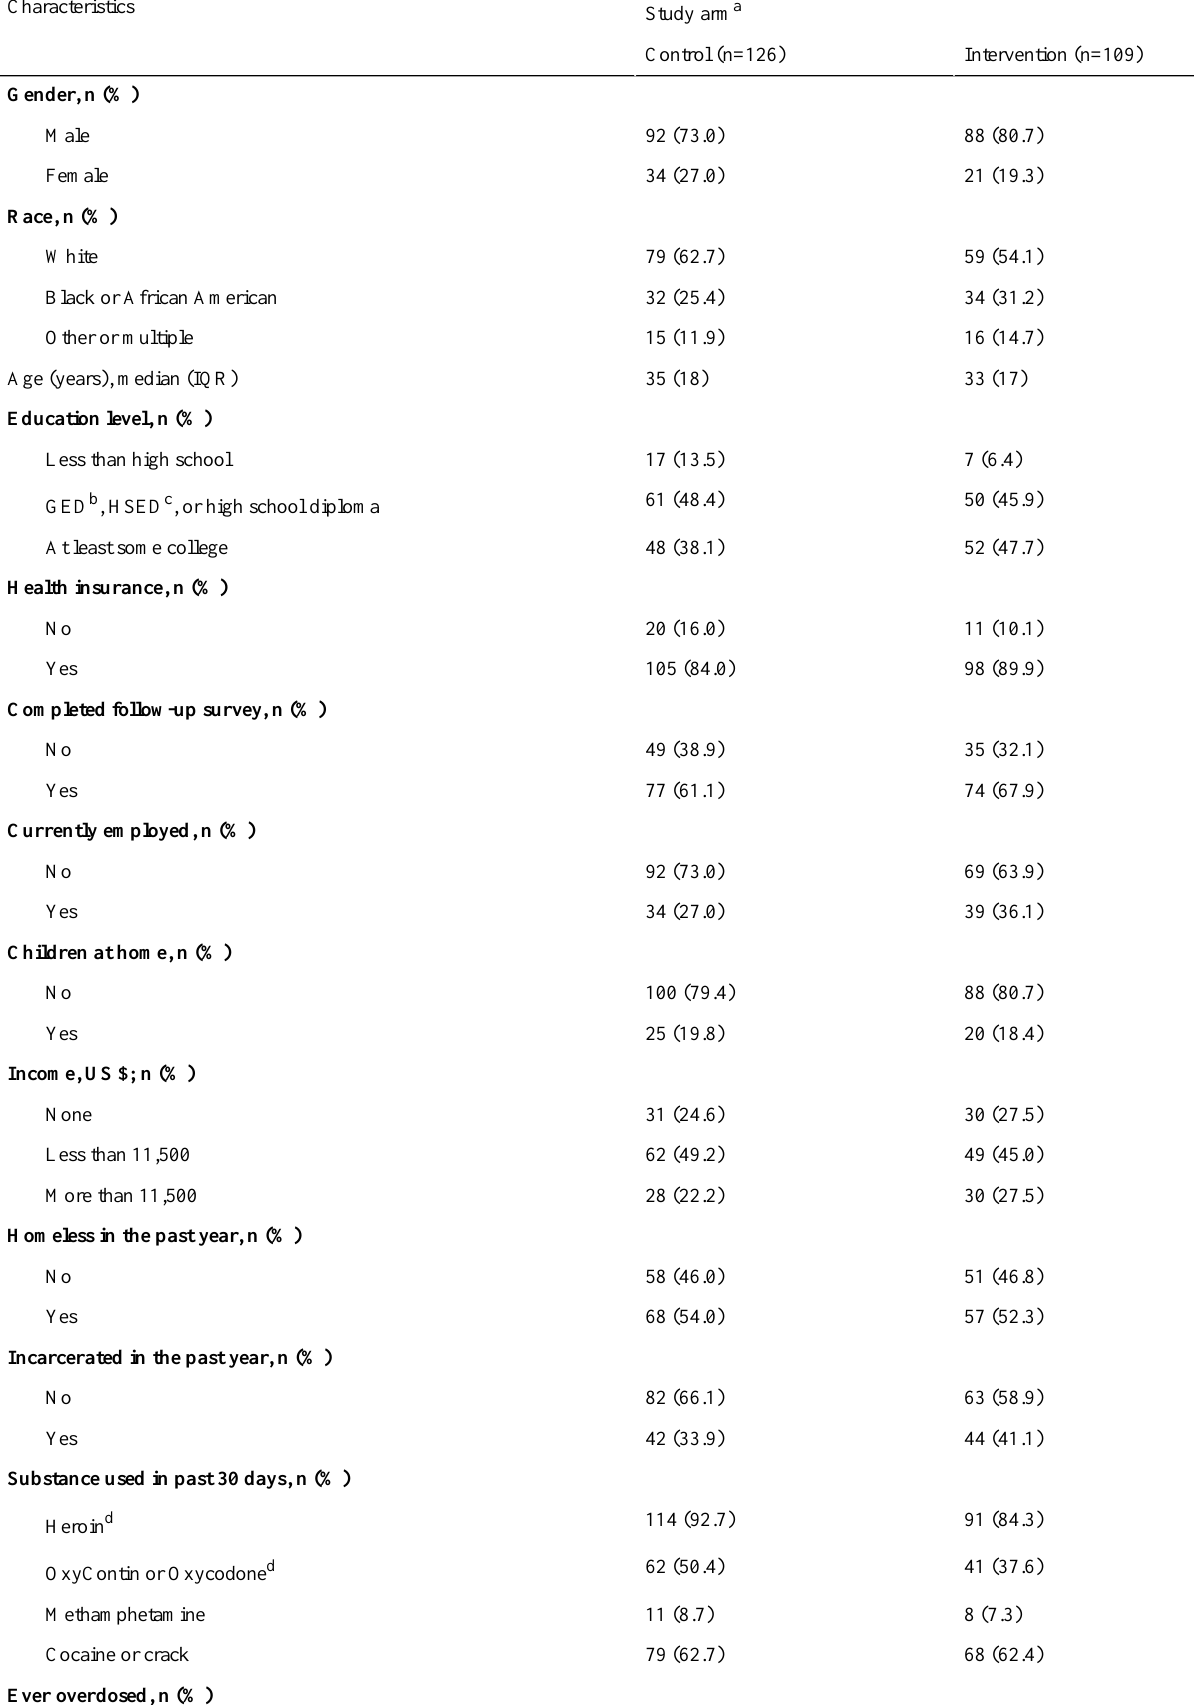
Table 1. Baseline demographic characteristics by intervention and control arm